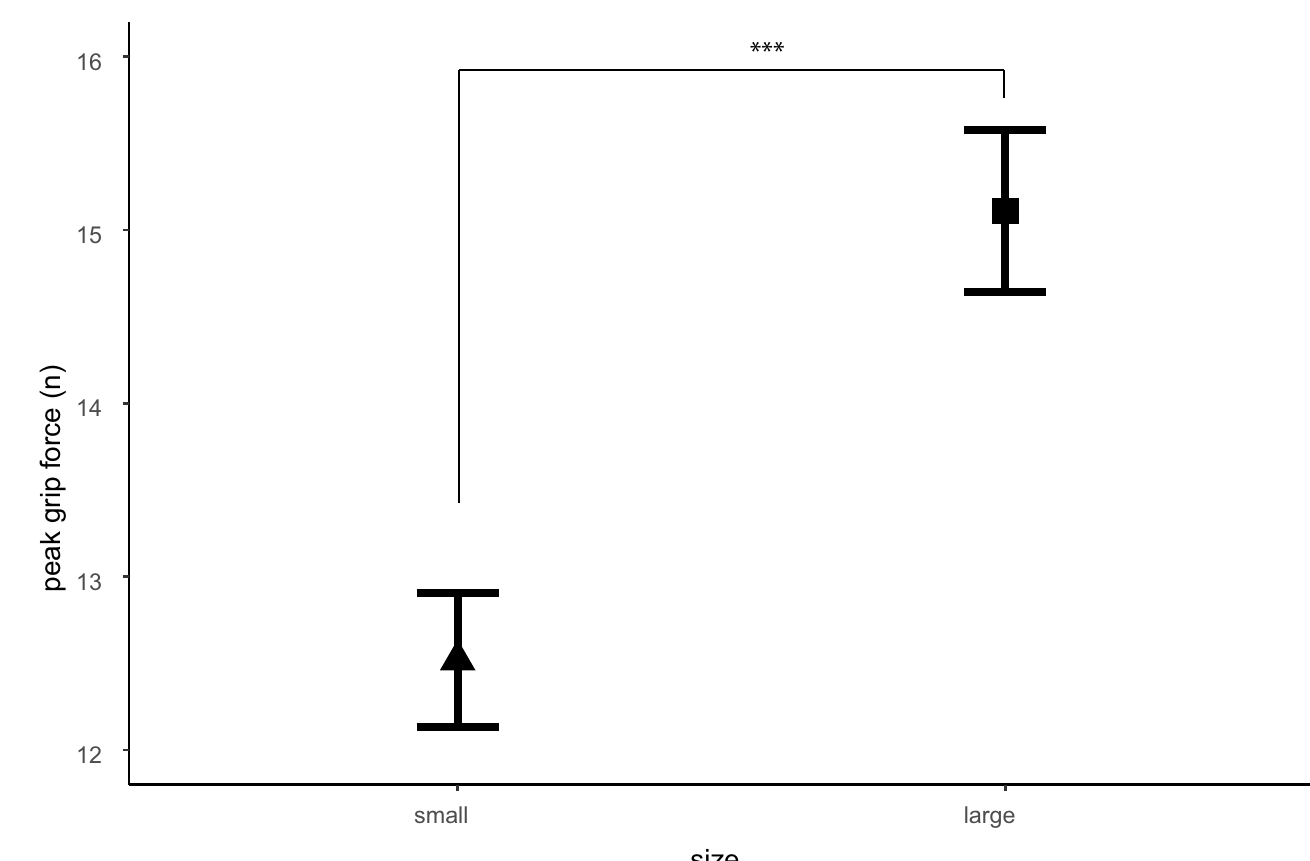
Fig 4. Main effect of size for grip force peak. Participants show higher peaks in grip force for the larger object.